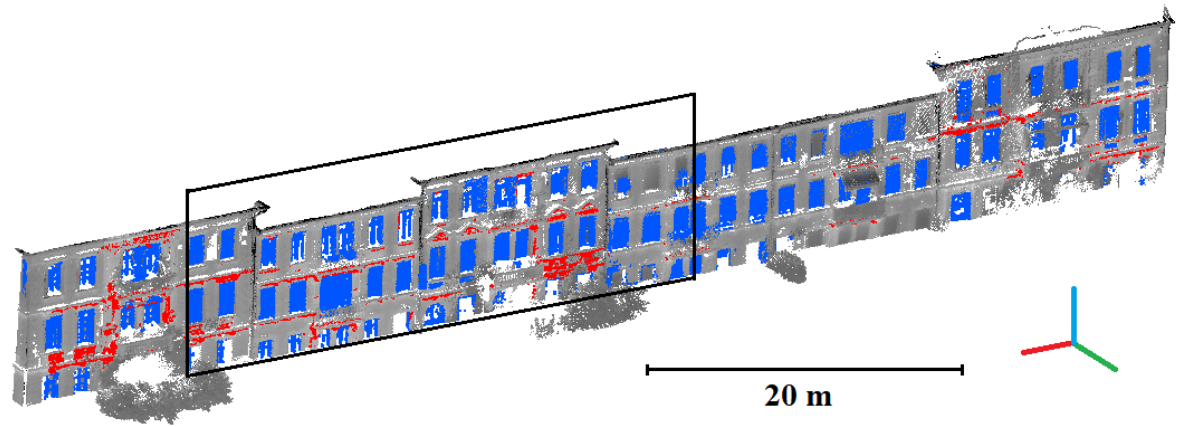
Figure 5: Result of the developed approach: windows in blue and thermal bridges in red